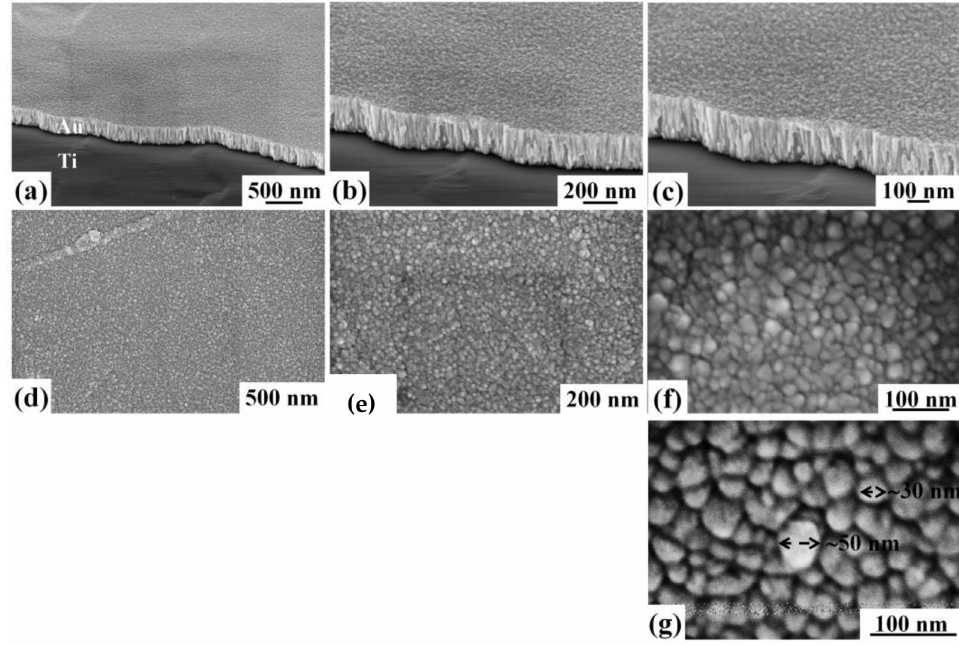
Figure 2. Cross-section (( a – c ), with magnification increase from ( a ) to ( c )) and plan-view (( d – g ), with magnification increase from ( d ) to ( g )) SEM images of the thinner (220 nm-thick) Au film deposited at θ = 0 ◦ on Ti (sample A1).